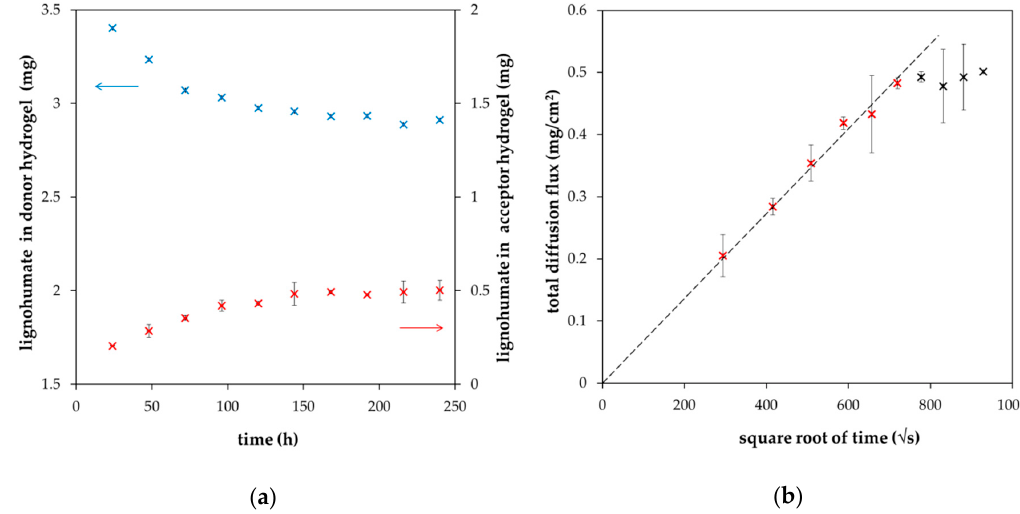
Figure 1. The time development of total amounts of lignohumate in donor (blue) and acceptor (red) hydrogels ( a ); experimental data fitted by Equation (2) ( b ).